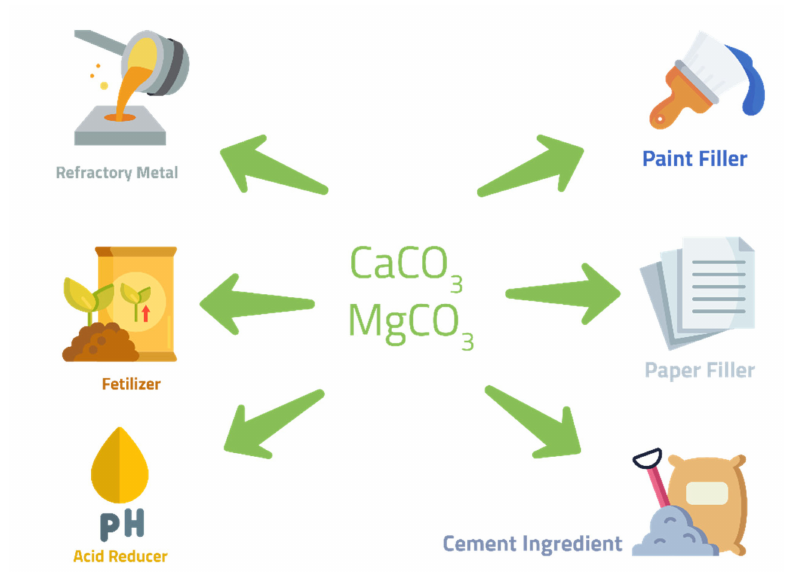
Figure 2. Industrial applications of carbonate